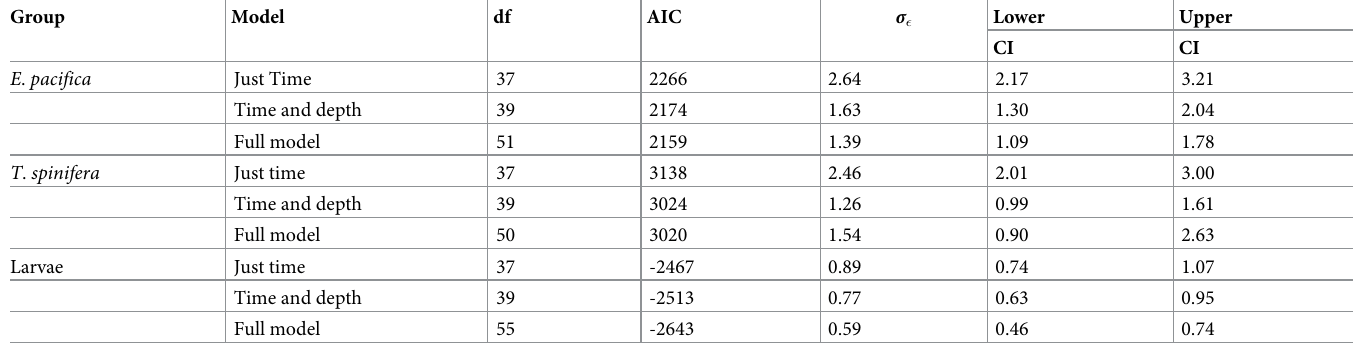
Confidence intervals (CIs) are at the 95% level.